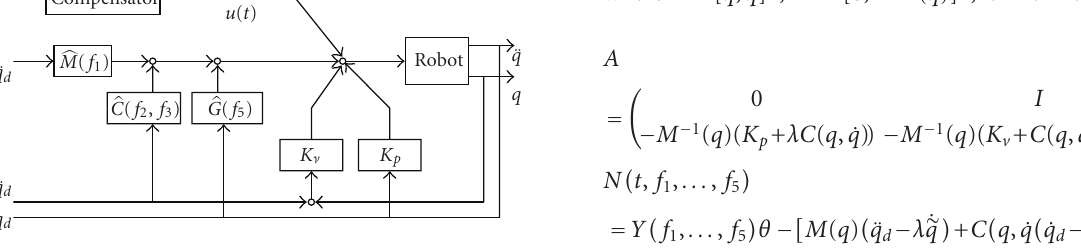
Figure 1: Schematic diagram of proposed PD plus feedforward robust